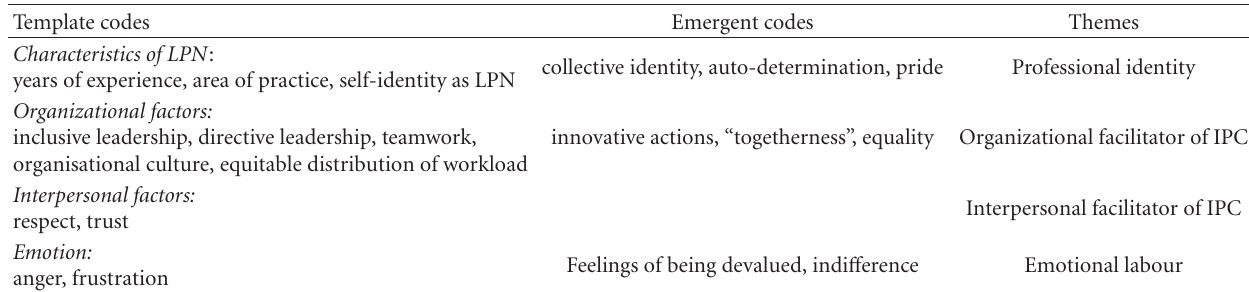
Table 1: Template codes, emergent codes and